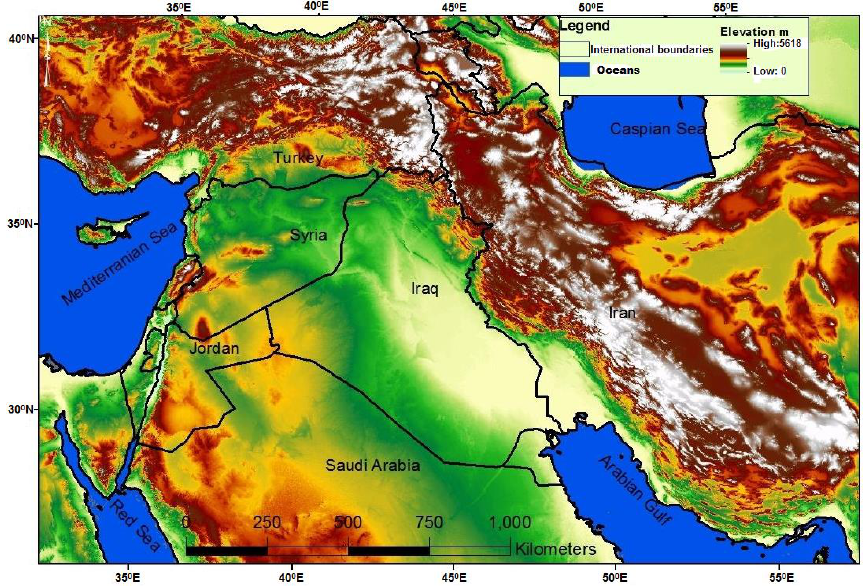
Figure.1 Regional and geographical setting of Iraq (SRTM 90 m topography map overlay by the international boundaries).